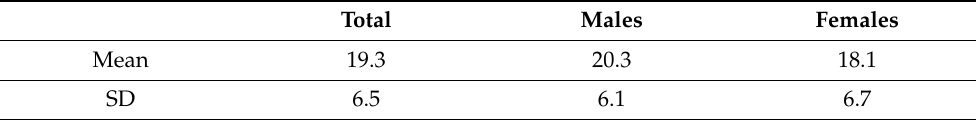
Table 4. BHK quality mean values by